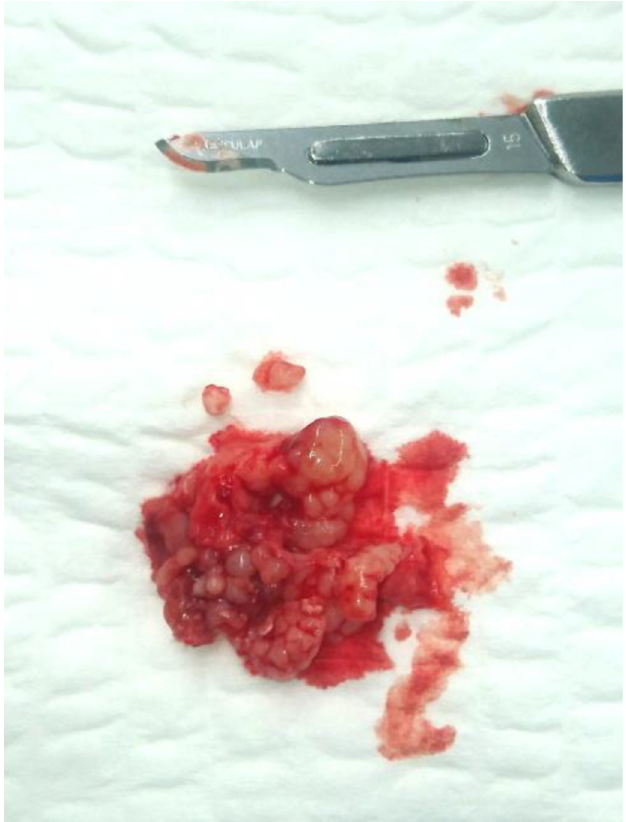
Fig. 4. Operatory piece: Lesion found inside the